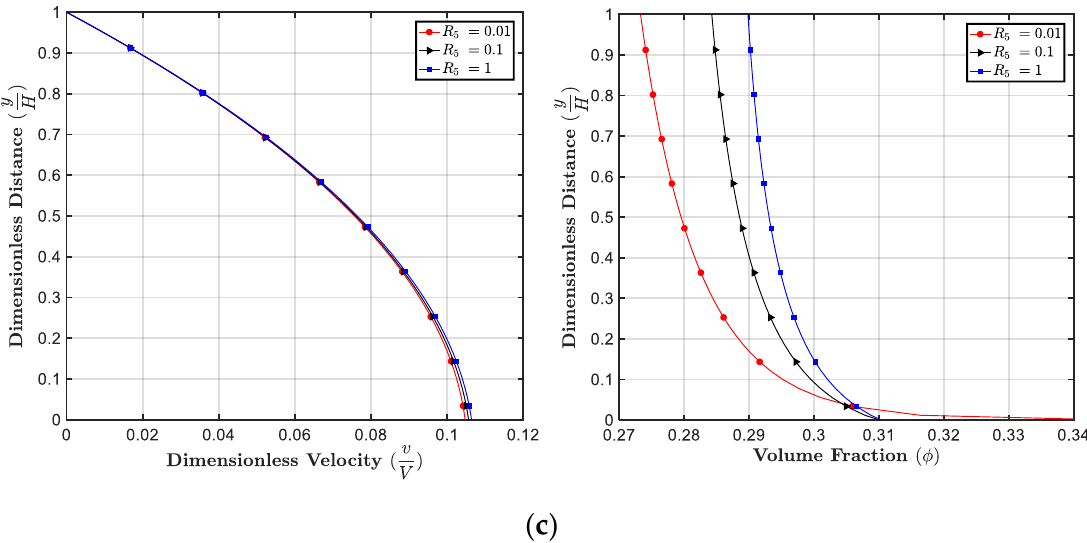
Figure 15. ( a ) Effect of R 3 on the velocity and the volume fraction profiles, with 𝛽 = 1.82, 𝜙 𝑎𝑣𝑔 = 0.3, 𝑅 0 = 0.1, 𝑅 1 = − 2.5, 𝑅 2 = 0.1, 𝑅 4 = 0.07, 𝑅 5 = 1.8, 𝐾 𝑐 = 0.05, φ m = 0.65, m = 1, θ = 45 ◦ ; ( b ) effect of R 4 on the velocity and volume fraction profile, with β = 1.82, φ avg = 0.3, R 0 = 0.1, R 1 = − 2.5, R 2 = 0.1, R 3 = 0.01, R 5 = 1.8, K c = 0.05, 𝜙 𝑚 = 0.65, 𝑚 = 1, 𝜃 = 45°; and ( c ) effect of 𝑅 5 on the velocity and volume fraction profile, with β = 1.82, φ avg = 0.3, R 0 = 0.1, R 1 = − 2.5, R 2 = 0.1, R 3 = 0.01, R 4 = 0.07, 𝐾 𝑐 = 0.05, 𝜙 𝑚 = 0.65, 𝑚 = 1, 𝜃 = 45°.